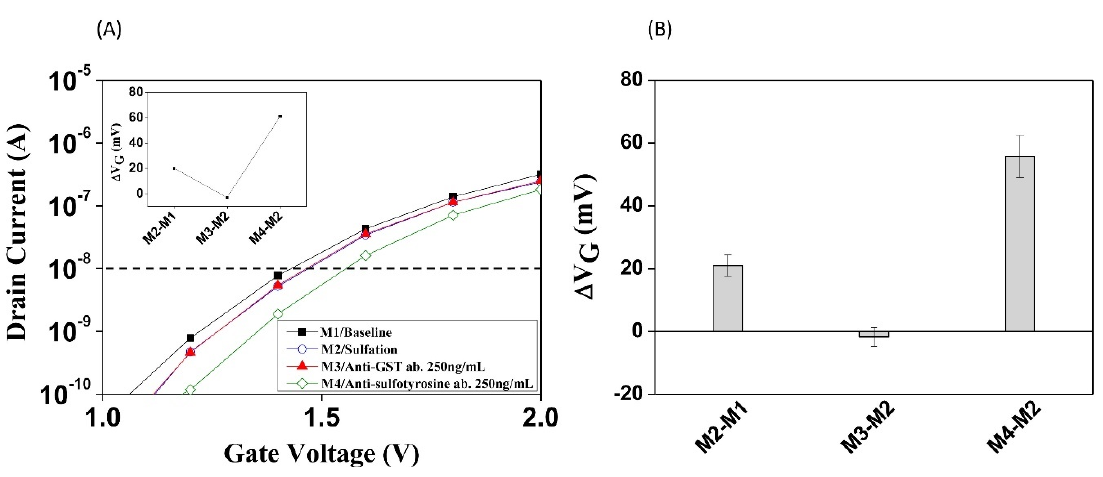
Figure 6. Electrical responses of the functionalized pSNWFET to PSGL-1 sulfation ( A ) Nonsulfated PSGL-1 peptide on the pSNWFET surface as the baseline (M1). I D –V G curve obtained through PSGL-1 sulfation (M2) and interaction with anti-sulfotyrosine (M4), and anti-GST antibodies as the controls (M3). ( B ) Average Δ V G value of Figure 6A.